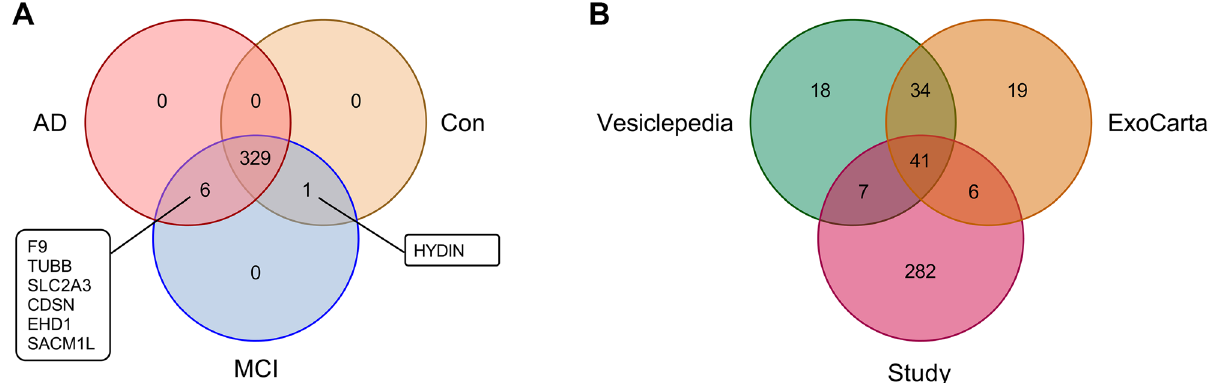
Figure 2. Visual representations of common and unique identified proteins amongst study groups and the EV databases based on Venn diagrams. ( A ) A total of 336 proteins are identified, with 329 common proteins for all groups, one protein common between healthy controls and MCI patients, and six proteins common between AD and MCI patients. No proteins are uniquely expressed in a single group. ( B ) With 336 proteins identified in this study, a total of 54 proteins overlap with top 100 proteins from the EV databases Vesiclepedia and ExoCarta, with 41 proteins shared between all three lists.